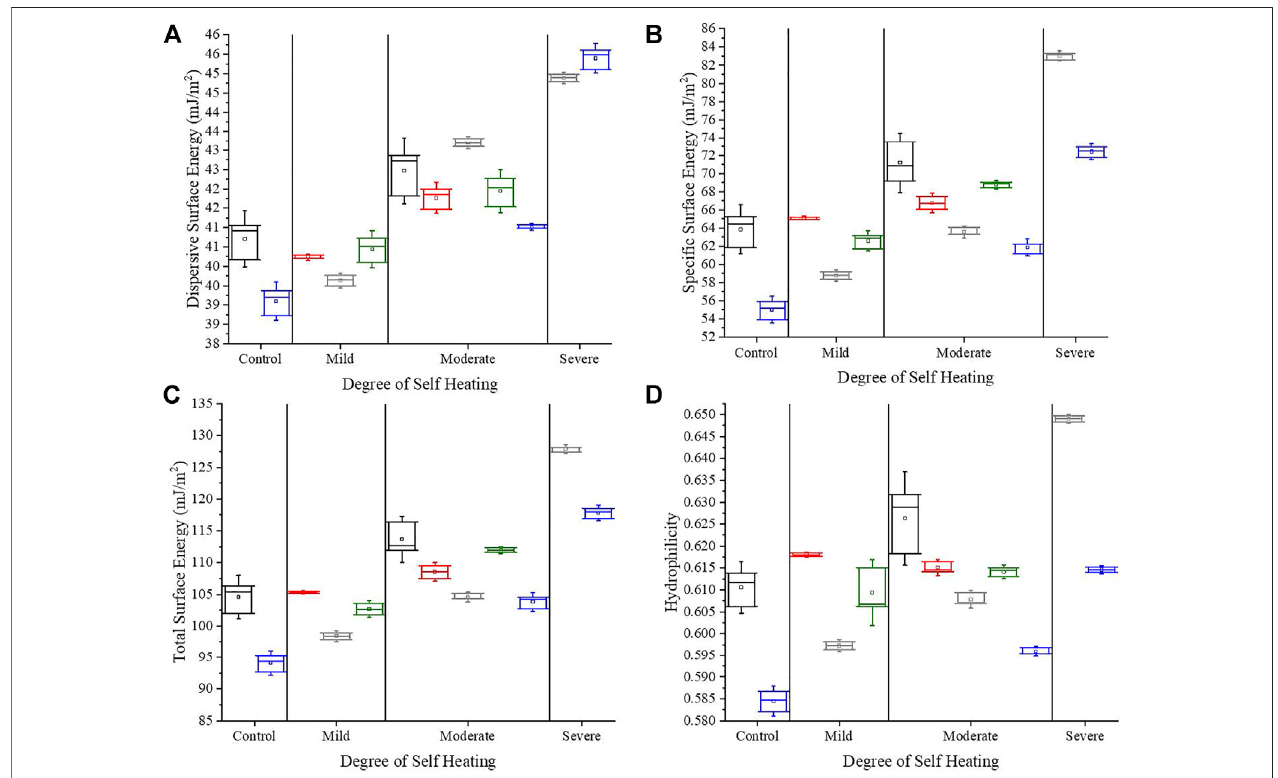
FIGURE 5 | (A) Dispersive, (B) speci fi c, (C) total surface energy and (D) hydrophilicity of bulk bale samples; □ Bale 1, □ Bale 2, □ Bale 3, □ Bale 5, □ Bale 6 [box upper and lower limit = data max. and min., whiskers = sample standard deviation (Coeff. 1.5), solid horizontal line = median, hollow internal box = mean].